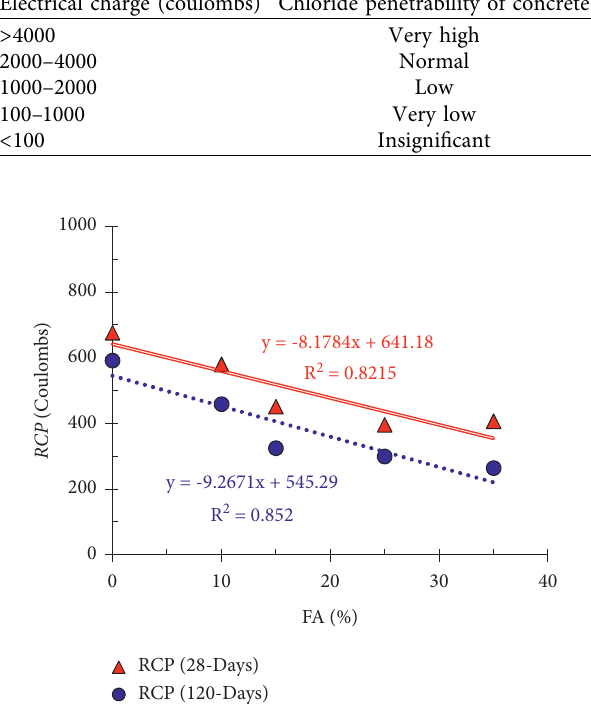
Figure 18: Relationship between FA content in binder and cor- responding RCP values of HSC.